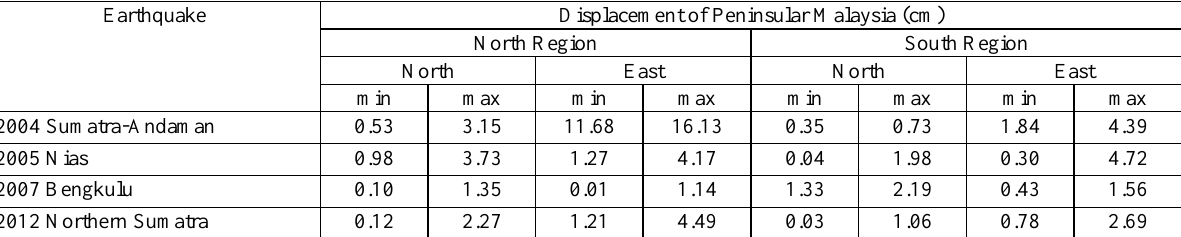
Table 6. Maximum and minimum co-seismic displacements in Peninsular Malaysia due to the four major